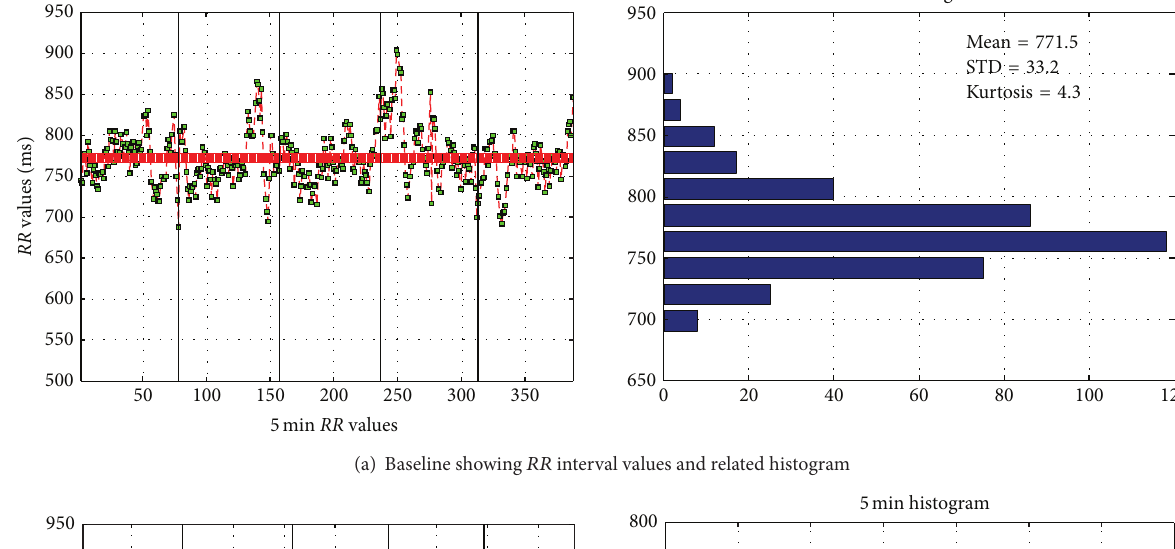
(a) Baseline showing 𝑅𝑅 interval values and related histogram